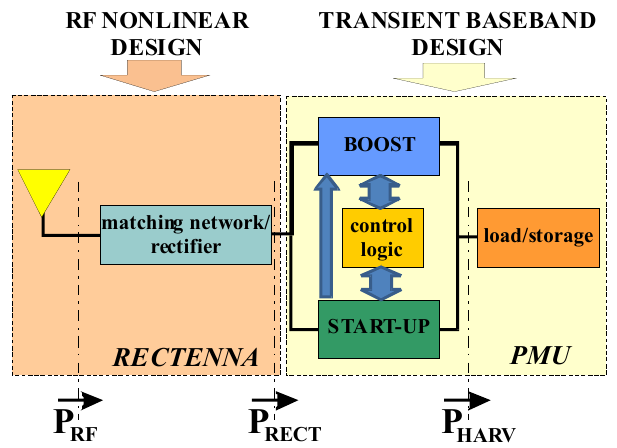
Figure 2. Block diagram of the multi-domain CAD tool for rectenna